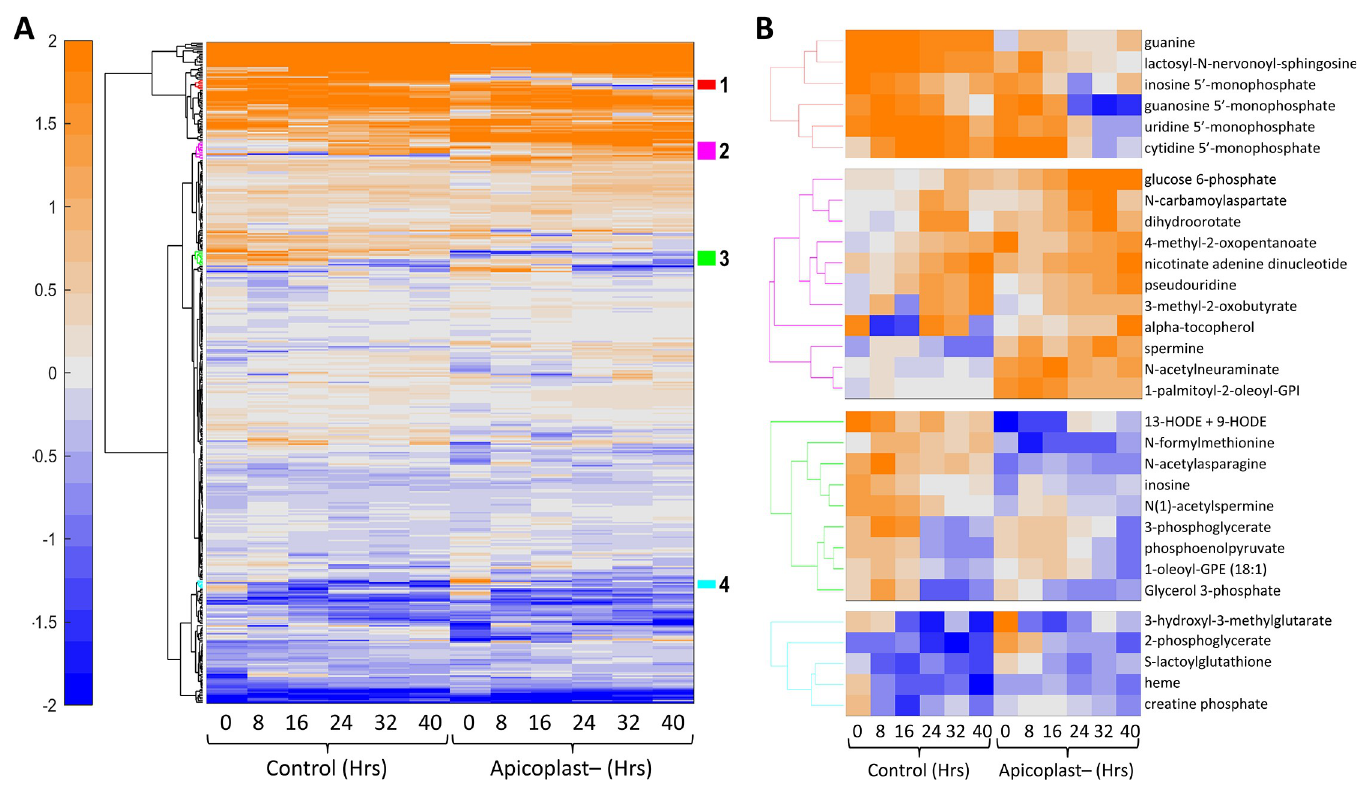
Fig 8. Metabolomic analysis of apicoplast-disrupted parasites. A) Hierarchical clustering of metabolomic data from control and apicoplast-disrupted parasites at the indicated time points. Metabolomic data are shown for 405 metabolites that are present in both data sets. The data represent the abundance of each metabolite after normalization with their median value at the sampled time points. The hierarchical clustering method is the same as described above, except that we also used the k- nearest-neighbor method to impute any missing values in the data. The values are shown on a log 2 scale with orange and blue colors indicating amounts higher and lower than the median value, respectively. B) Four clusters of metabolites that have temporal profiles which differ between control and apicoplast-disrupted parasites are colored in red, magenta, green, and